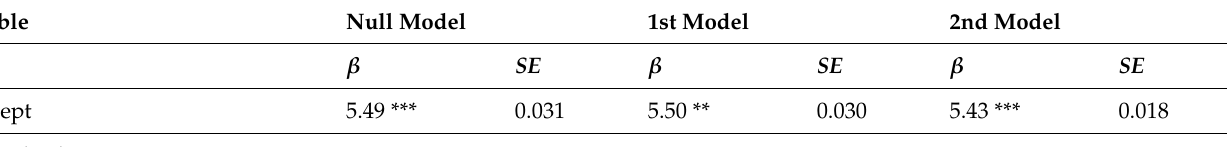
Table 8. The coefficients of the hierarchical linear regression